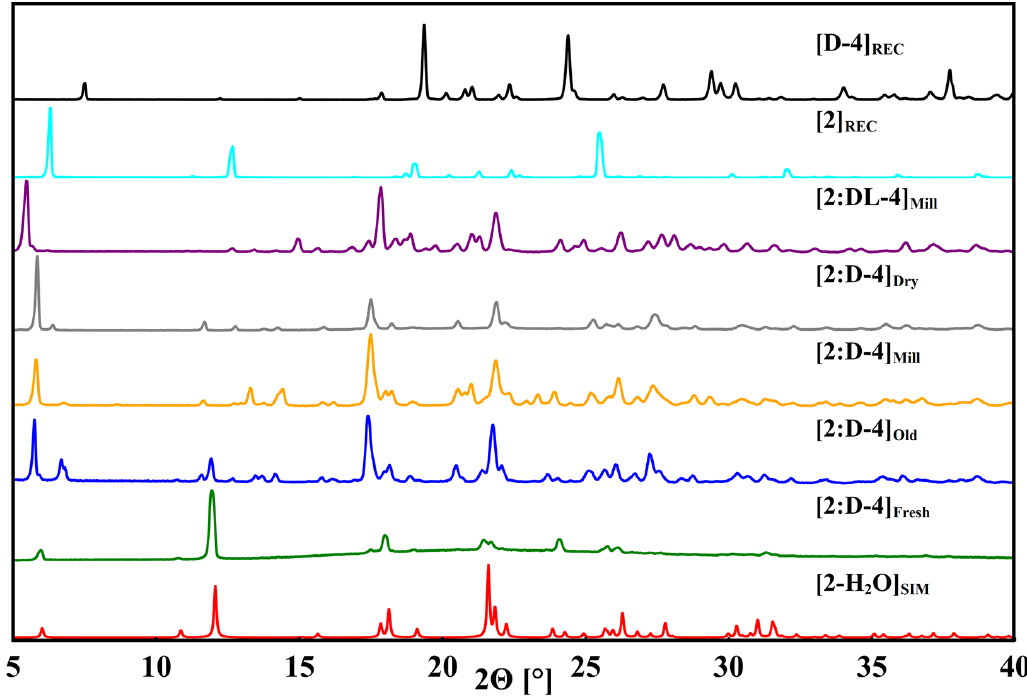
Figure 11 . Selected PXRDs received from crystallization experiments involving Phenibut and malic acid in a range 2–40° 2 Θ are compared to the simulated 2 • H 2 O (red) and recorded 2 (cyan) and D − 4 (black) pattern: (green) freshly prepared sample with D − malic acid from aqueous solution; (blue) six months old sample of Phenibut and D − malic acid from aqueous solution; (orange) 2 : D − 4 sample produced by methanol-assisted co-milling; (grey) Phenibut and D − malic acid from aqueous solution after vacuum drying; (purple) a co-milling sample of Phenibut and DL − malic acid.